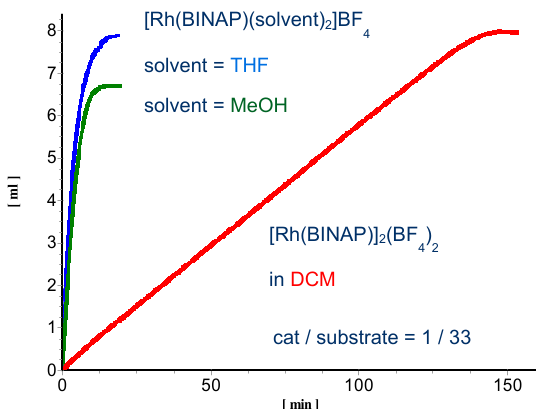
Figure 17. Hydrogen uptake (ml) as a function of time (min) in the reductive cyclization of 1,6 diyne as promoted by [Rh(BINAP)(THF) 2 ]BF 4 in THF, blue curve, [Rh(BINAP)(MeOH) 2 ]BF 4 in MeOH, green curve, and [Rh(BINAP)] 2 (BF 4 ) 2 in DCM, red curve. In all cases reactions were run using 0.01 mmol catalyst ([Rh(BINAP)] 22+ ), 0.33 mmol diyne, at 25 °C in 10 mL solvent under normal hydrogen pressure.